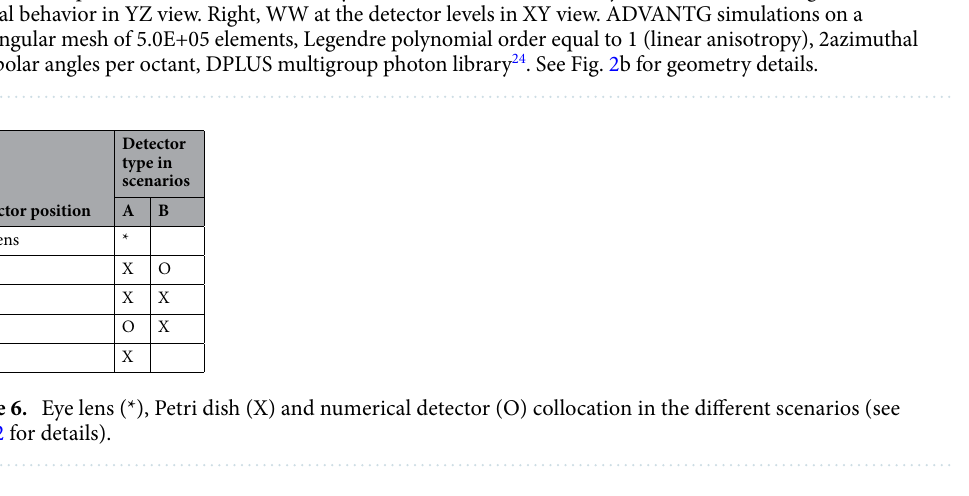
Figure 5. Importance function evaluated by the ADVANTG tool. Left, adjoint flux. Centre, Weight Window typical behavior in YZ view. Right, WW at the detector levels in XY view. ADVANTG simulations on a